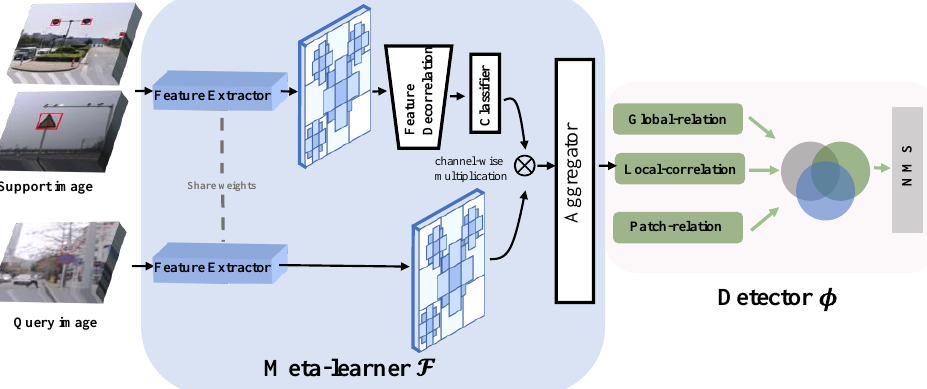
Figure 2. The architecture of our proposed Meta-YOLO. It comprises a meta-learner model and a detector model. The weights of the obtained query features and support features are shared by the feature extractor utilizing the YOLOv4 backbone network. The aggregator outputs the category detection results by combining the query features with the category features associated to the target instance in the support images received by the decorrelation module and the classifier. To perform feature multi-scale detection, a multi-relational detector module with a three-head mechanism is employed.